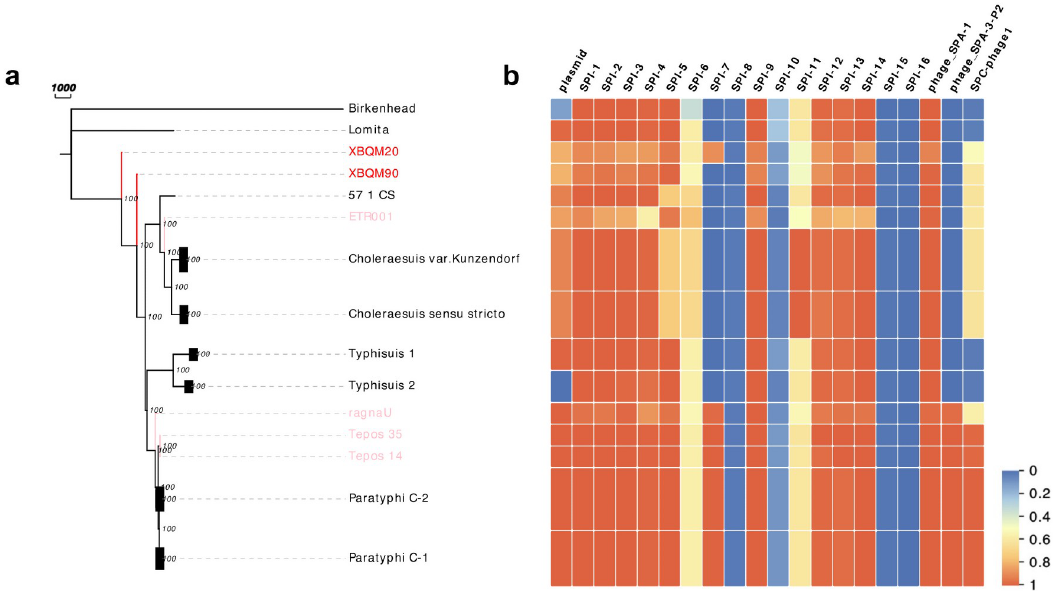
Fig 4. Phylogenetic tree of the Para C lineage and the gain and loss of virulence factors. A. Maximum parsimony tree of the Para C lineage. Paratyphi C, Typhisuis and Choleraesuis strains are collapsed based on their predicted serovar in order to better represent the relevant information and the Birkenhead serovar was used as the outgroup. B. Covered percentage of Salmonella virulence factors including the pSPCV plasmid, Salmonella pathogenicity islands (SPI1-SPI16) and prophages. For grouped strains, such as Paratyphi, Typhisuis and Choleraesuis, we showed the average percentage of covered